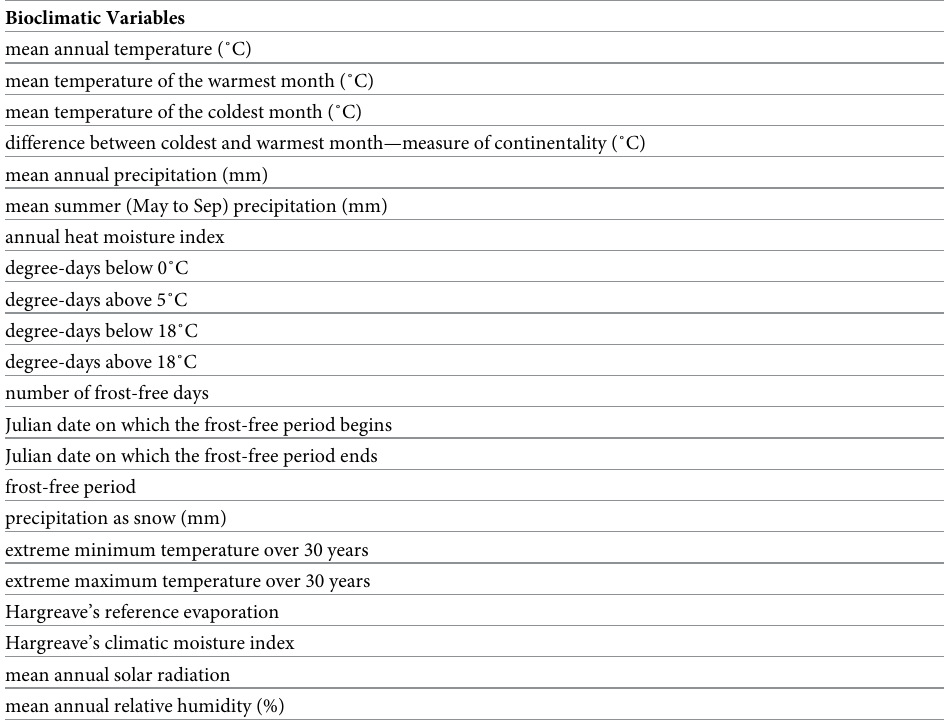
Table 2. Bioclimatic variables. Twenty-three ecologically relevant bioclimatic variables provided by Adaptwest (http://adaptwest.databasin.org/pages/adaptwest-climatena). These variables were used as predictors to build climate envelope models of Kenai Peninsula vegetation